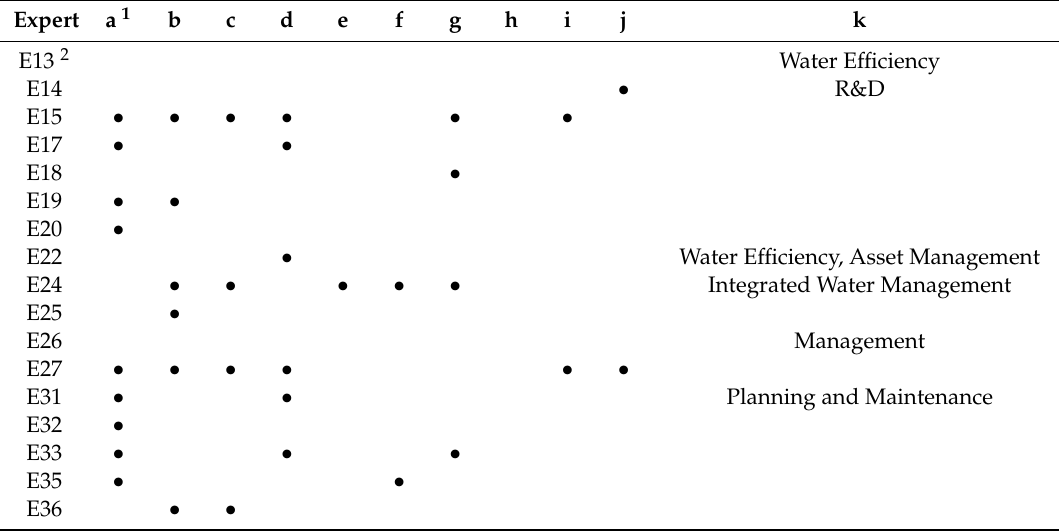
Table A1. The business area experience of industry